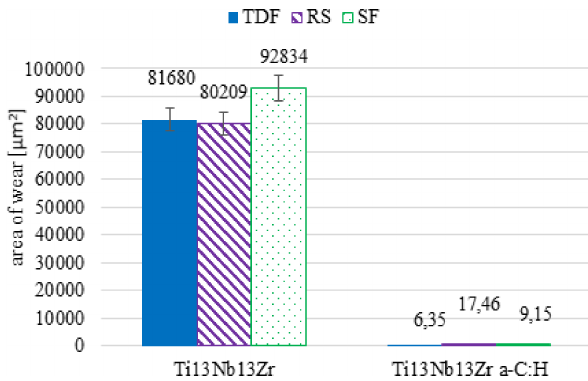
Figure 15: The isometric image of the trace of wear and the wear profile in a cross-section for Ti13Nb13Zr a-C:H a) TDF, b) RS, c) SF